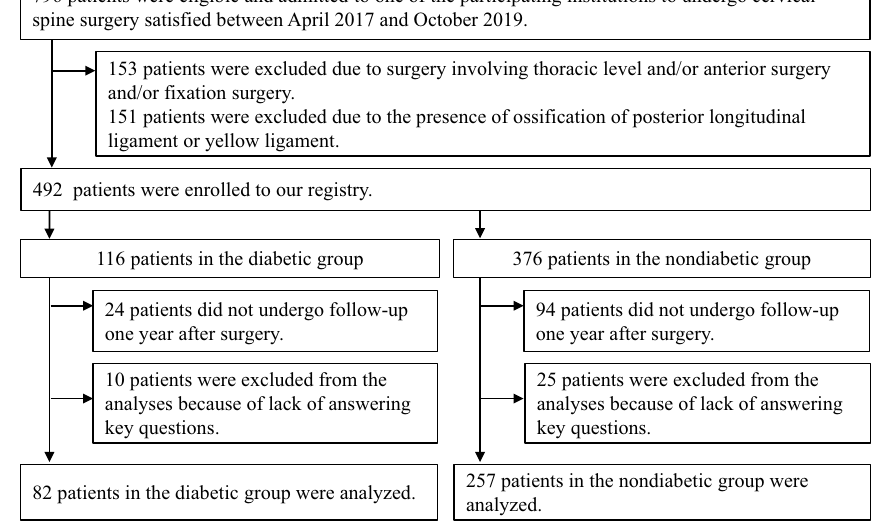
257 patients in the nondiabetic group were analyzed.